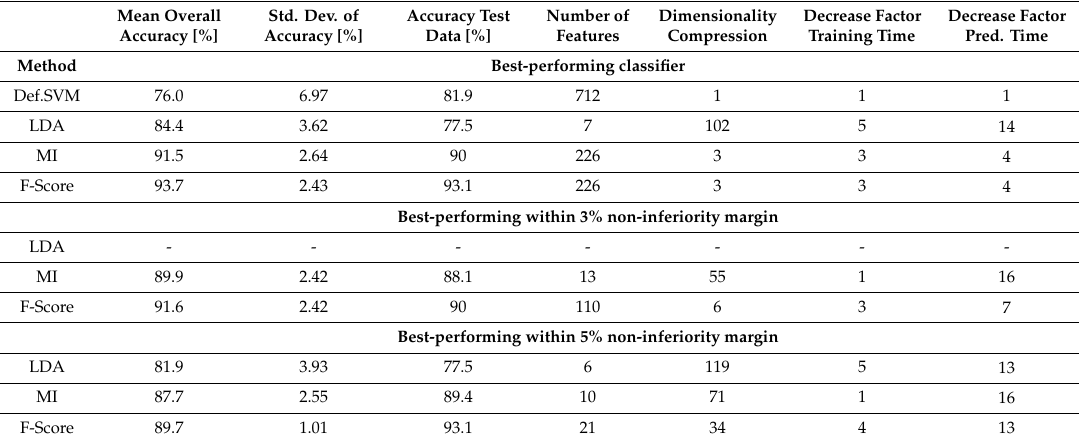
Table 8. Overview of the best performing classifiers